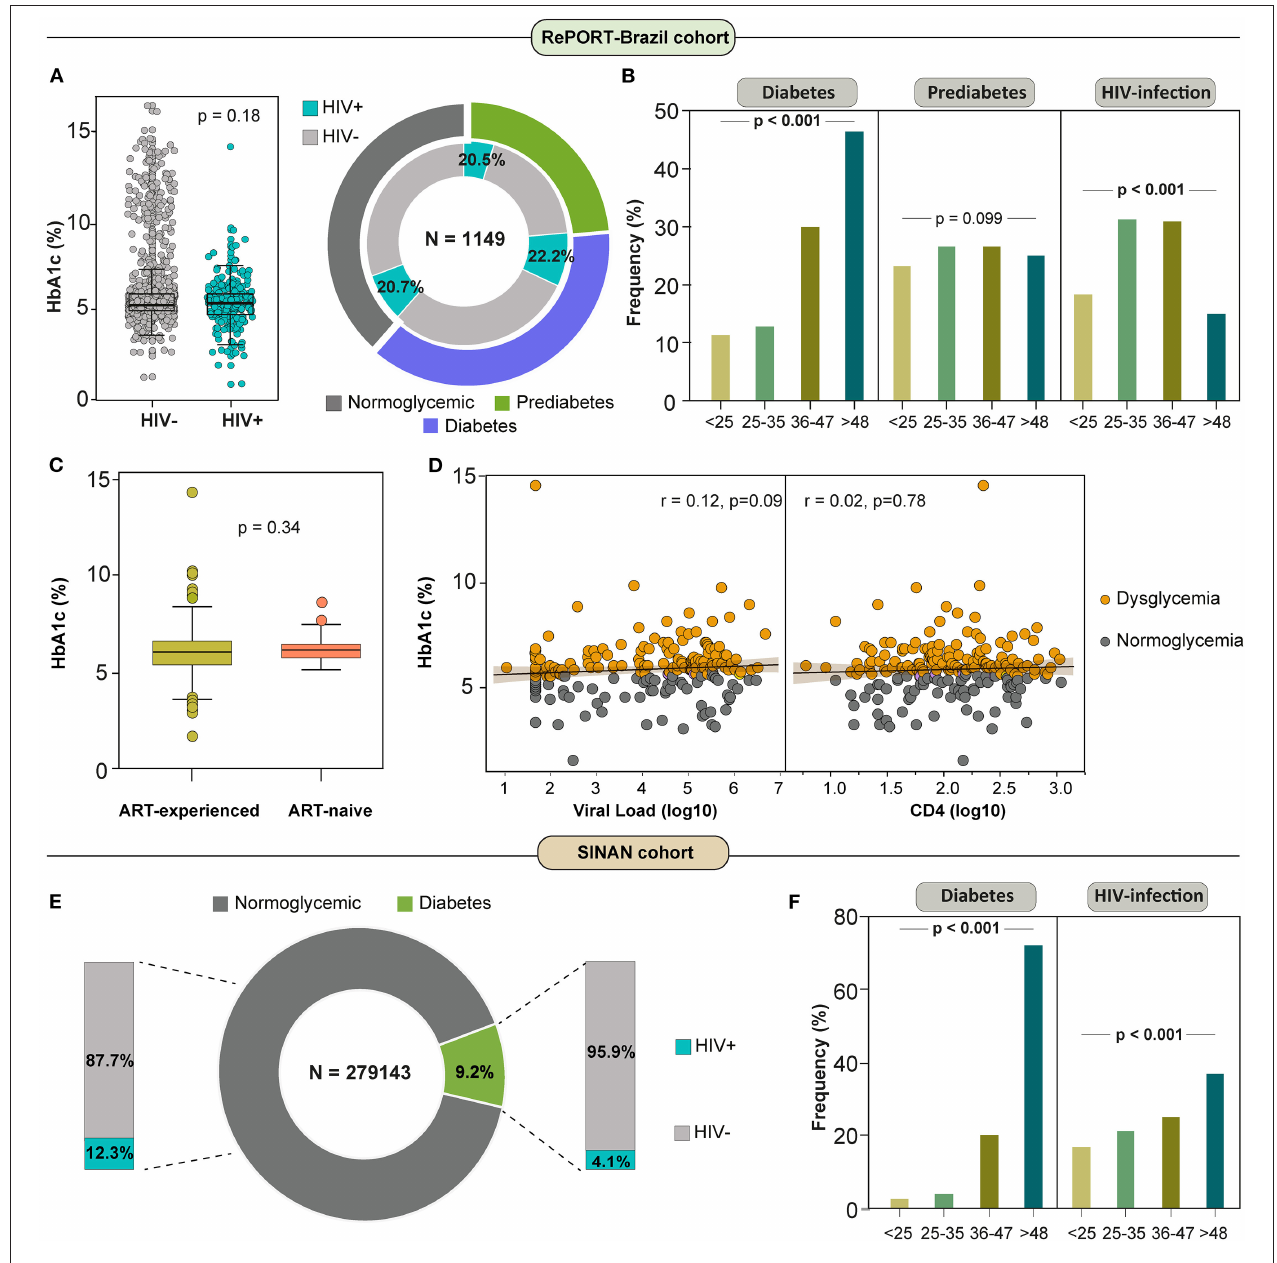
FIGURE 1 | HIV infection among dysglycemic patients with active tuberculosis in RePORT-Brazil and SINAN cohorts. (A) Left panel: Scatter plot comparing distribution of HbA1c levels between subgroups of pulmonary TB cases per HIV infection status. Data were compared using the Mann-Whitney U test. Left panel: Total frequency of HIV infection among diabetic TB patients was 20.5%, among prediabetics was 22 · 2% and among normoglycemic patients was 20.7% (chi-square test p > 0 · 05). (B) Frequency of individuals with diagnosis of diabetes, prediabetes and HIV infection in the indicated age category (in years) among pulmonary TB patients is shown. Data were compared using the Pearson’s chi-square test. (C) Box plot comparing distribution of HbA1c levels between subgroups of pulmonary TB cases per ART-experience and ART-naive status. Data were compared using the Mann-Whitney U test. (D) Spearman correlation between HbA1c and viral load (log10) levels (Left panel) and CD4 (log10) levels (Right panel) at baseline in pulmonary TB patients grouped according to the dysglycemic status. Line and shaded area represent linear curve fit with 95% confidence interval. (E) Total frequency of HIV infection among diabetic TB patients was 4.1% and among normoglycemic patients was 12.3% (chi-square test p > 0 · 05). The statistical analyzes were carried out only with the available data, omitting the cases with missing information (14 patients were removed due to lack in HIV status). (F) Frequency of individuals with diagnosis of diabetes and HIV infection in the indicated age category (in years) among pulmonary TB patients is shown. Data were compared using the Pearson’s chi-square test. ART, antiretroviral therapy.